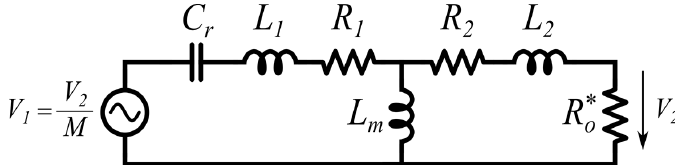
Figure 10. Modified FHA LLC equivalent circuit with distributed inductances and resistances.